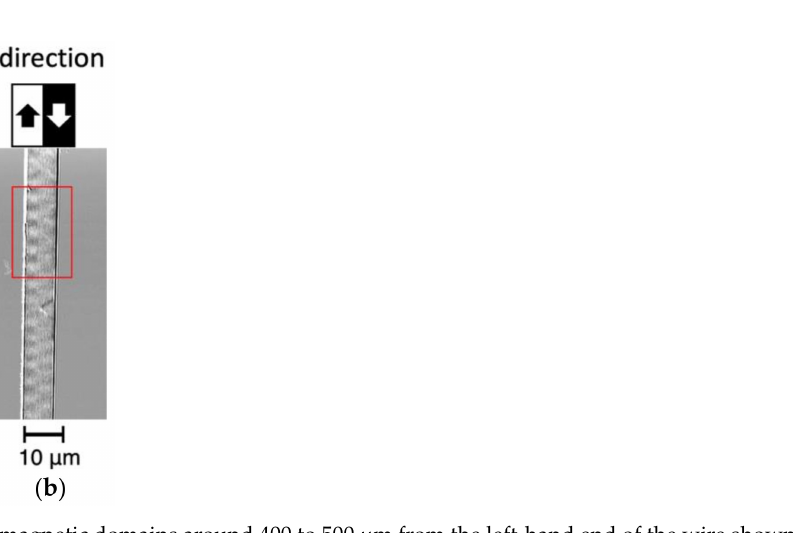
Figure 4. Image of magnetic domains around 400 to 500 µ m from the left-hand end of the wire shown in Figure 2: ( a ) radial magnetic domain pattern and ( b ) axial magnetic domain pattern.